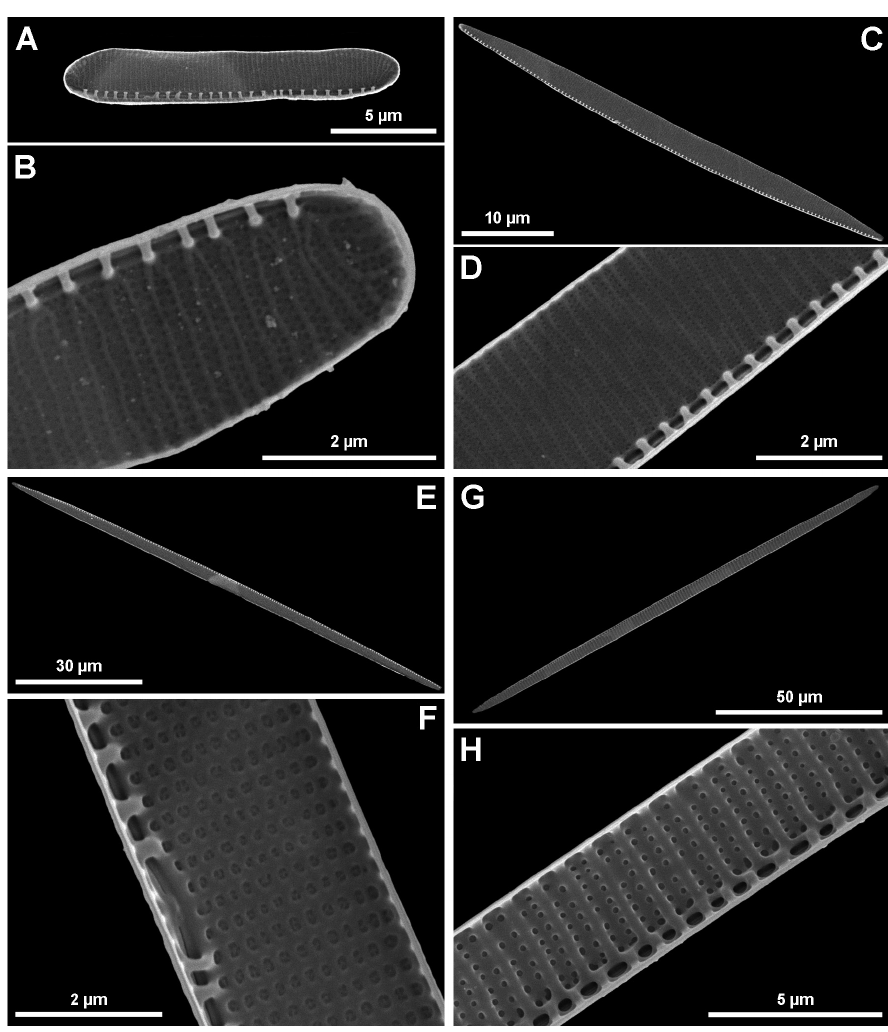
Fig . 3. – Scanning electron microscopy micrographs of Pseudo-nitzschia species: A and B, P. linea ; C and D, P . multistriata ; E and F, P . cf mannii ; G and H, P. pungens clade